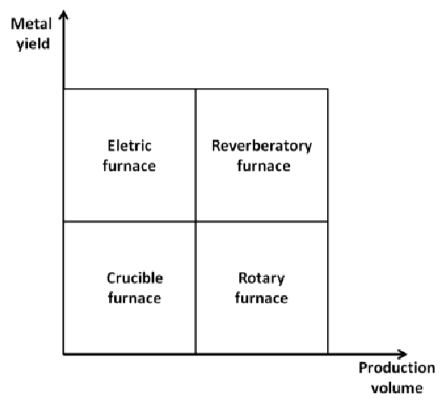
Figure 11. Criteria for melting furnace selection during Al